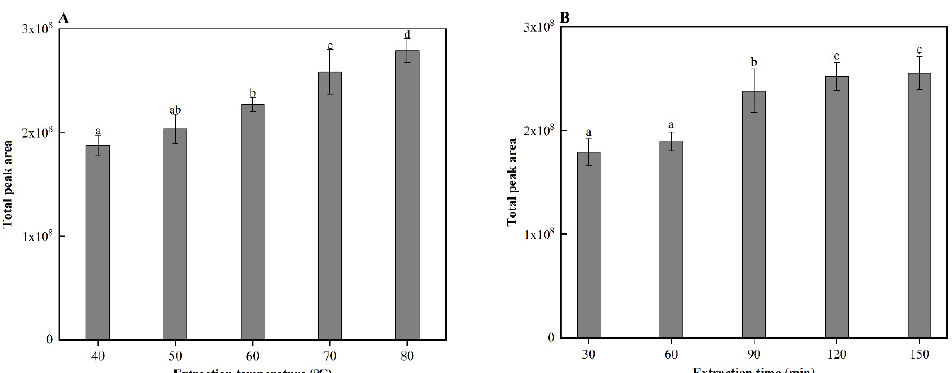
Figure 1. ( A ) extraction temperatures, and ( B ) extraction times of solid-phase microextraction (SPME) with corresponding gas chromatography-mass spectrometry (GC-MS) peak areas. Different letters indicate significant differences in values ( p < 0.5).